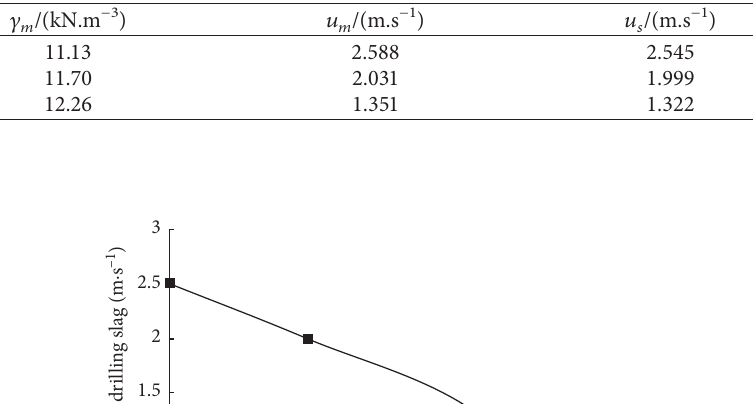
Table 1: Arising velocity parameters of intermixture, boring mud, and drilling.